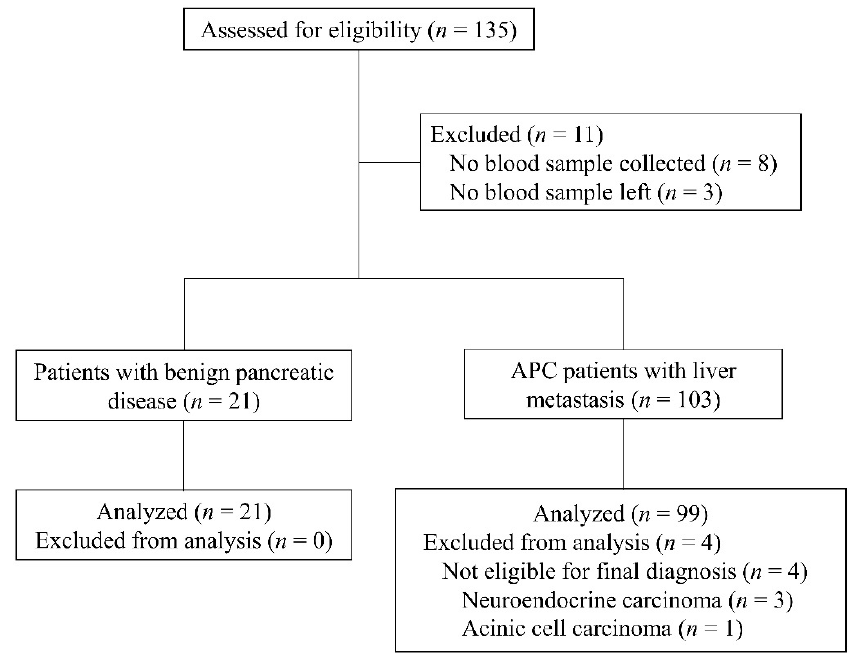
Figure 1. Consort diagram. APC, advanced pancreatic cancer. Mean (± standard deviation [SD]) serum GDF-15 levels were significantly higher in the 99 patients with liver metastasis of APC (2990.2 ± 1967.0 pg/mL) than in the 21 patients with benign disease (1177.0 ± 1089.8 pg/mL; p < 0.001) (Figure 2). The cut-off value was determined as 3356.6 pg/mL, representing the mean plus twice the SD of the serum GDF- 15 level in patients with benign disease, (Figure 2). As a result, 34.3% ( n = 34) of the 99 APC patients were classified as the high-GDF-15 group. Mean serum GDF-15 levels were 5257.0 ± 1649.9 pg/mL in the high-GDF-15 group and 1804.5 ± 602.5 pg/mL in the low-GDF-15